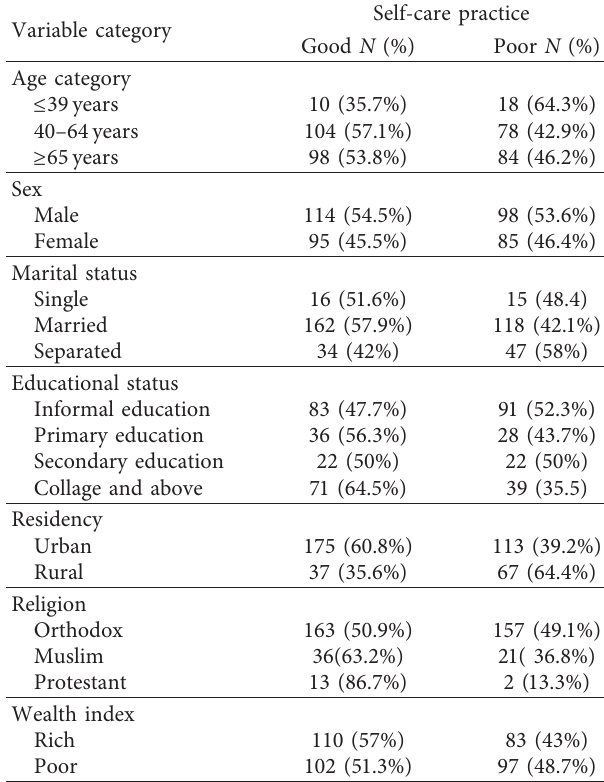
Table 1: Sociodemographic characteristics of hypertensive patients in Debre Tabor Referral Hospital, Northwest Ethiopia,